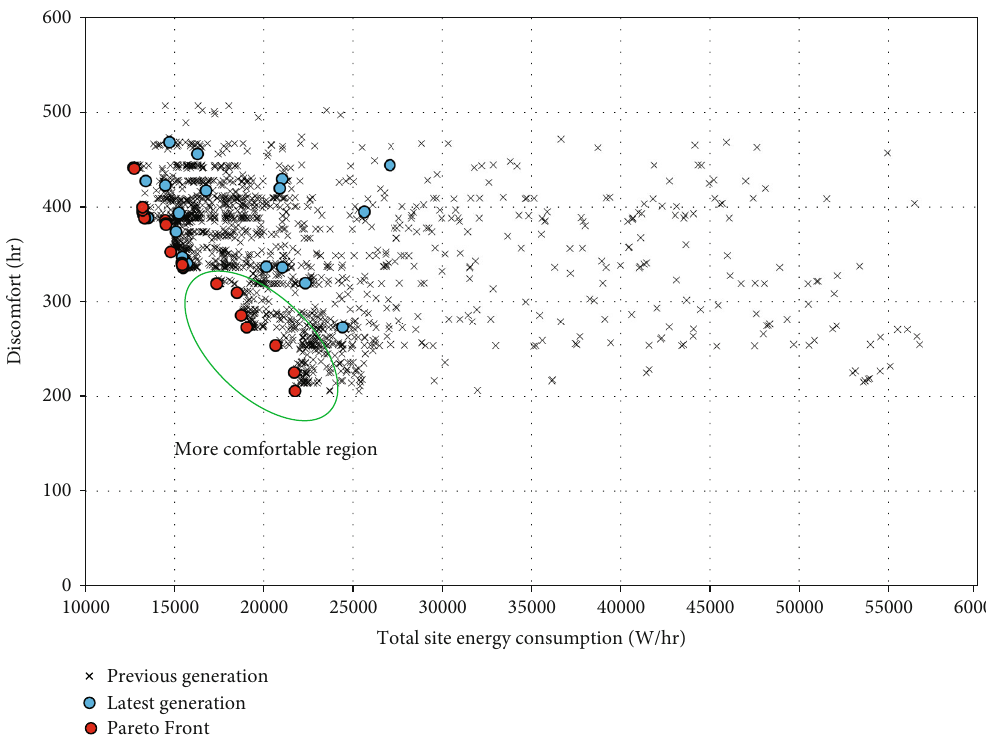
Figure 9: The optimization results and determination of Pareto Front for most optimized